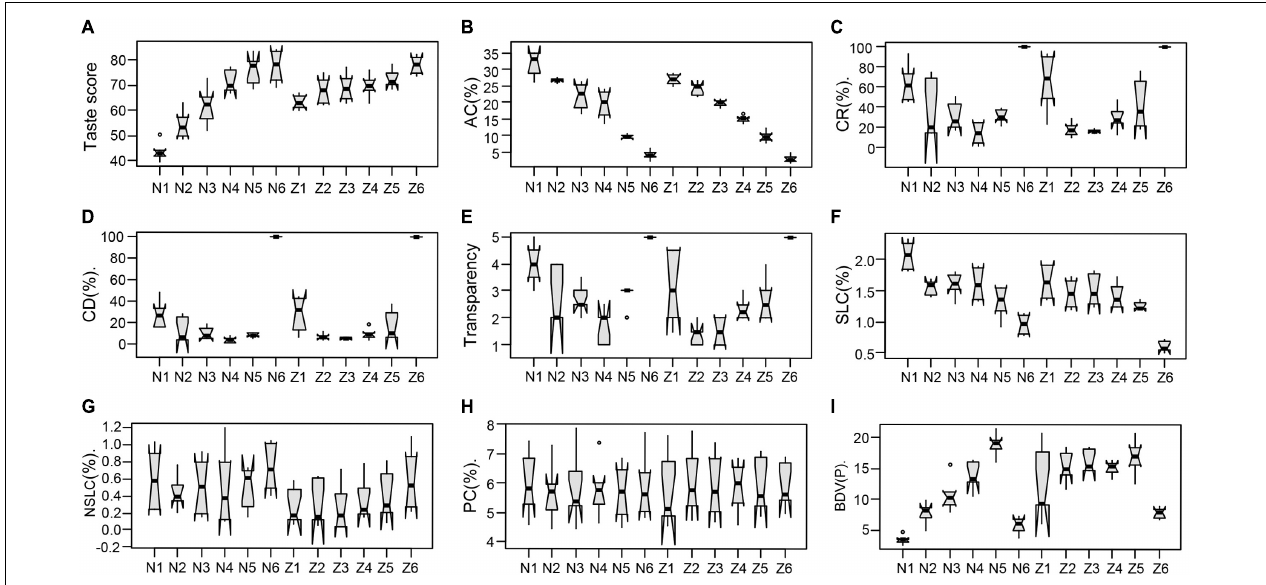
FIGURE 2 | Effects of Wx genotype on quality traits. (A) Taste score, (B) AC, (C) chalkiness rate (CR), (D) chalkiness degree (CD), (E) transparency, (F) starch-lipids content (SLC), (G) non-starch-lipids content (NSLC), (H) grain protein content (PC), and (I) breakdown viscosity (BDV). N1–N6 are NILs Nip- Wx lv , Nip- Wx a , Nip- Wx in , Nip- Wx b , Nip- Wx mp , and Nip- wx ; and Z1–Z6 are transformants ZN- Wx lv , ZN- Wx in , ZN- Wx b , ZN- Wx la , ZN- Wx mp , and ZN- wx